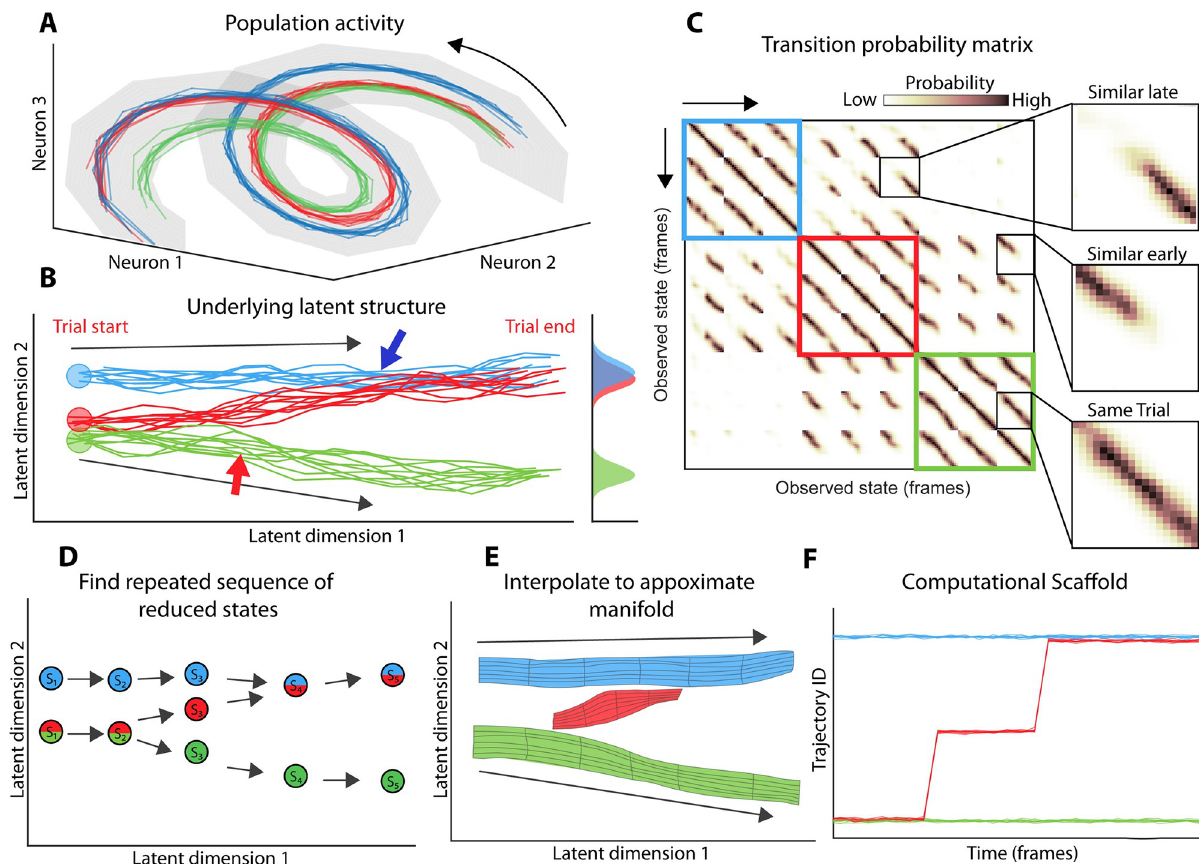
Fig 1. Schematic of LOOPER—A method for constructing simple models of nonlinear dynamical systems based on experimental observations. Overview : A ) Activity of a hypothetical system given by three neurons. The state of this system is characterized by the neuronal population activity vector, which records the instantaneous firing of all neurons (Neurons 1, 2 and 3). Note that the activity is confined to a helical manifold. Time is implicit and flows in the direction indicated by arrows in A through F . In this example, neuronal activity is recorded under three different task conditions shown by color in A-F . B) Diffusion mapping is used to unwrap the helical structure in A to reveal a simpler (2D) projection that contains all of the neuronal activity. While the unwrapped space is 2-dimensional, the actual dynamics of the system are largely confined to a set of three one dimensional trajectories each starting from a unique set of initial conditions (red, green and blue circles). So long as trajectories stay separate, the information stored in the state of the system is preserved. At the moment when red and blue trajectories merge, the system is no longer able to distinguish them (blue arrow). The merging of the trajectories can be quantified by the overlap in the distributions of neuronal activity (marginal histograms). On the contrary, the green trajectory is separated from the rest at the end of the trial. Thus, the distribution of the green points is distinct from the other two. C) Shows a diffusion map, normalized as a transition probability matrix, constructed from the observations in A . The three task conditions (three trials of each) are shown by three colored squares. The most likely transitions in each case are along the one off diagonal of the matrix. This corresponds to the actual observations. High transition probabilities away from this main diagonal correspond to similar dynamics observed on different trials. Note that the off diagonal bands appear late in the trials for blue and red conditions. In contrast, the green and red conditions are initially similar but diverge towards the end of the trial. D) Observations in C naturally inform a way to coarse grain the diffusion map. States characterized by similar transition probabilities (rows of the matrix in C ) can be readily aggregated. This results in a course grained transition probability matrix where each entry is a cluster of experimental observations aggregated on the basis of similarity of rows in the diffusion map in C . This coarse grained transition probability matrix is shown as a graph. The position of each state (S1, S2, S2 ... ) in the latent space is given by the mean of all experimental observations that comprise the state. Note that in this example transitions from each state (arrows) are predominantly to a single other state. This expresses the assumption that the most salient information can be represented by one dimensional trajectories. This assumption allows further simplification of the system by clustering states (S1, S2, ... ) into trajectories (ordered sequences of states). E) Finally, states within each trajectory are interpolated to reveal a model that consists entirely of one dimensional trajectoriess (each colored surface is a distinct trajectory). The width of each trajectory shows the variance of the experimental observations projected onto the latent space F) A useful way to describe the data is the “computational scaffold” which is the trajectory ID assigned to the observed data at each time point. Note that the data tends to separate out the initial conditions (red, green and blue) during the middle of the trial based on trajectory ID. Further, the way that the trajectories merge and split can give valuable insight into the types of information used by the